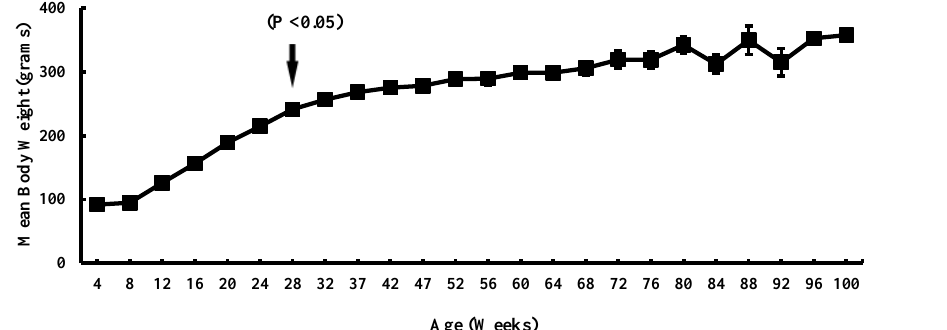
Figure 1. Mean body weight in the common marmoset from birth until 100 weeks of age ( n = 48). In the first 28 weeks a significant ( P < 0 . 05) (arrow) increase in the body weight was observed as compared with mean values at 24, 20 and 16 weeks of age.